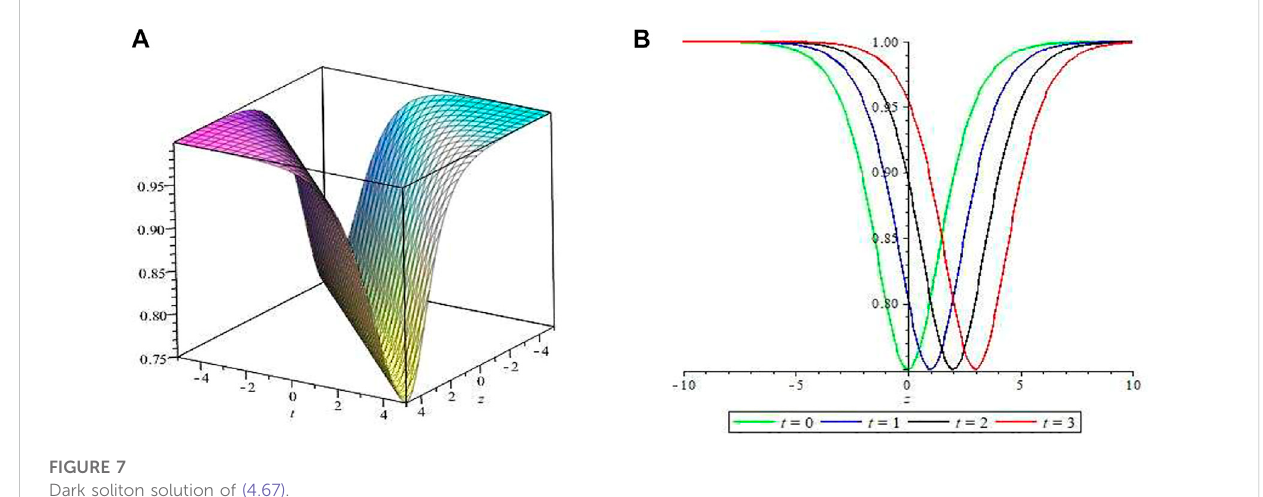
FIGURE 7 Dark soliton solution of